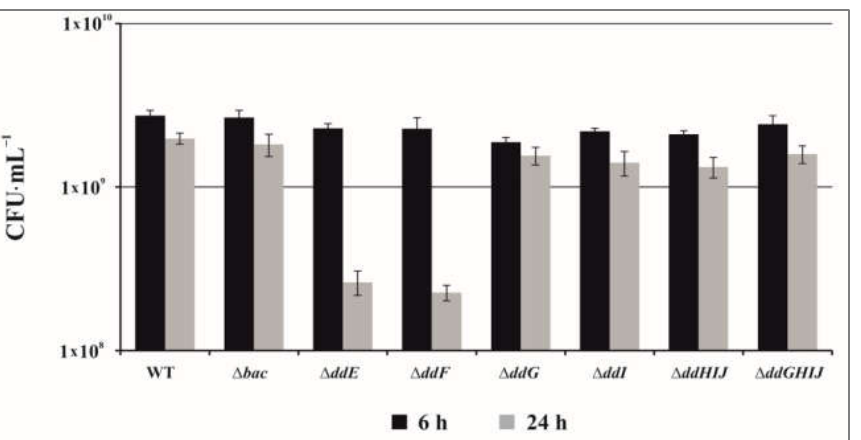
Figure 2. Survival of Enterococcus faecalis 14 and its mutant strains after 6 h and 24 h of growth in GM17. The data are the means of at least three independent experiments.